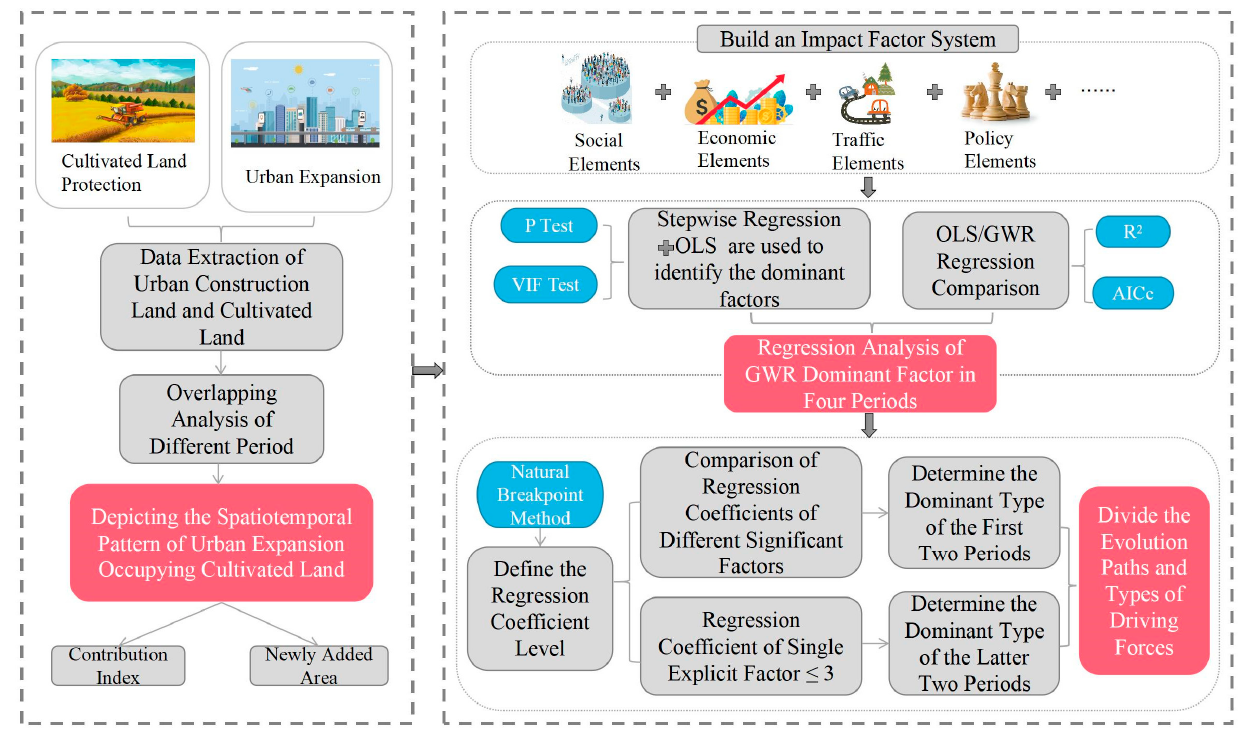
Figure 2. Technical flowchart. Table 1. The driving force system of cultivated land occupied by urban